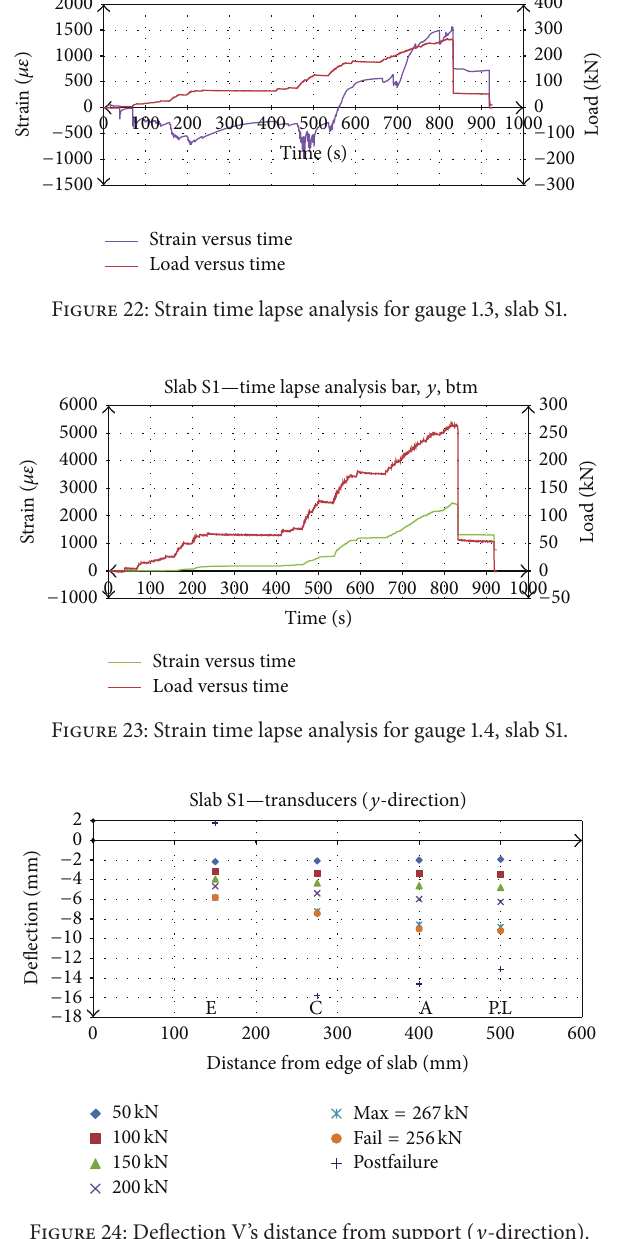
Figure 24: Deflection V’s distance from support ( 𝑦 -direction).